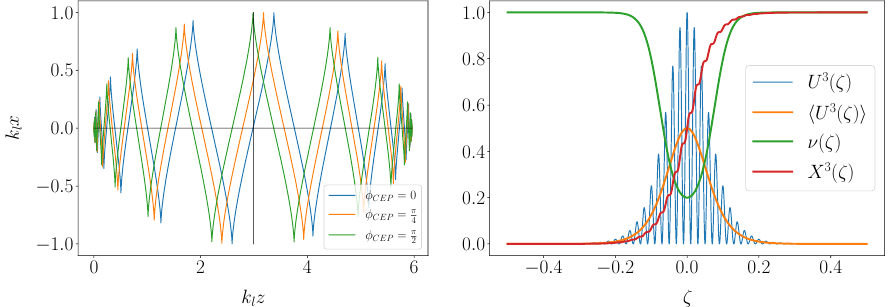
Figure 1. ( Left ): The electron trajectory for a head-on collision with a linearly polarized plane wave laser pulse (Equation (3) with Ψ = 1) for different values of φ cep . The laser pulse parameters are N c = 5 and a 0 = 2. For short pulses there are few oscillations near the maximum of the field. ( Right ): The longitudinal velocity (Equation (4)) and position of the electron during the interaction and the frequency it emits (Equation (6)) in normalized units. For the velocity, the drift velocity U 3 ( ) is also shown. As described in [10,22], a frequency that is emitted twice during the interaction (cid:104) (cid:105) can interfere constructively depending on the space–time distance of emission and lead to subsidiary peaks (see Figure